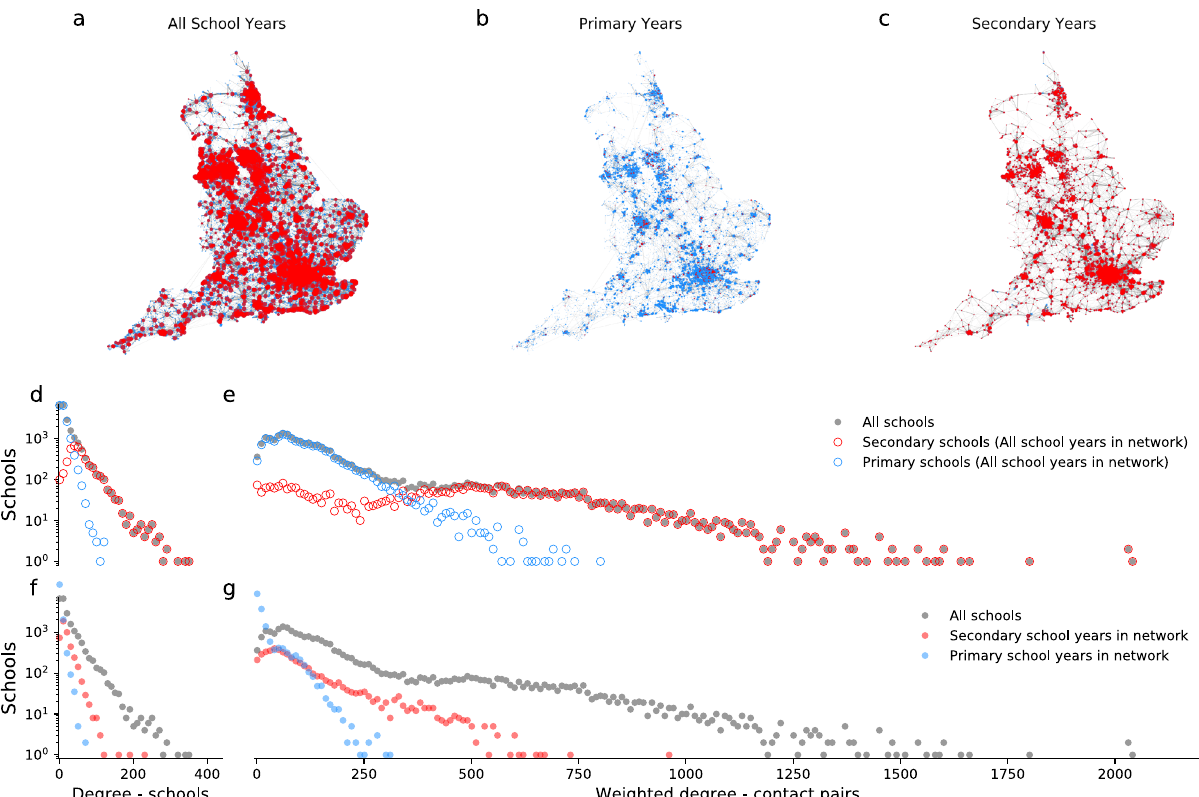
Fig. 1 School contact networks. Networks of contact through households between 21,608 state-funded schools in England plotted by location. a Network with all school years in attendance. b Network with only primary school years in attendance. c Network with only secondary school years in attendance. Nodes show schools with size determined by the weighted degree of the node (number of unique contact pairs with any other school). Edge widths that indicate the number of unique contact pairs between the schools the edge connects. Red nodes show secondary schools (mean age ≥ 11 years), blue nodes show primary schools (mean age <11 years). Followed by degree distributions of the networks of contact through households. d A histogram of the number of schools connected by at least one contact pair and e a histogram of the number of unique contact pairs with all other schools in the network including all school years (i.e. that shown in panel a ). for all schools (grey) dots, secondary schools (mean age ≥ 11 years, red circles), and primary schools (mean age <11 years, blue, circles). f A histogram of the number of schools connected by at least one contact pair and g a histogram of the number of unique contact pairs with all other schools in the network including all school years (grey), the network including only secondary school years (blue) and the network including only primary school years